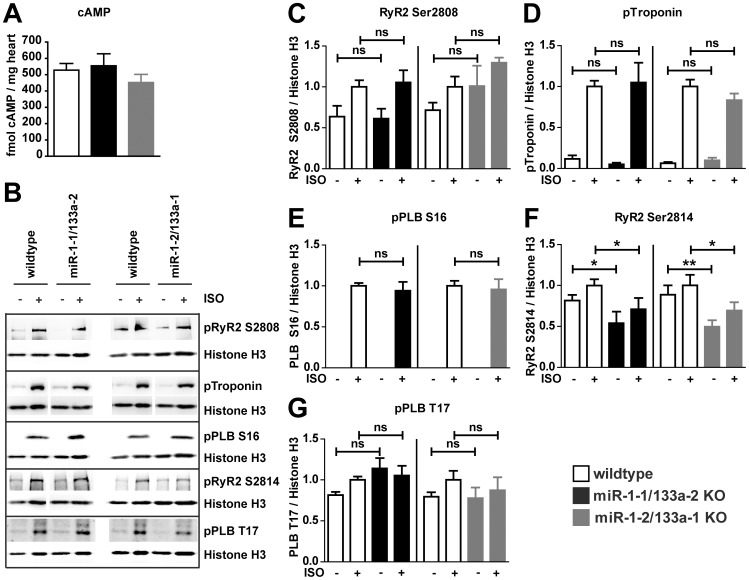
β-adrenergic signaling is intact in after loss of miR-1/133a.The concentration of cAMP was not changed in the adult heart of miR-1/133a single cluster mutant mice (A). Adrenergic signaling of cardiomyocytes isolated form adult hearts of WT and single miR-1/133a cluster mutant mice was investigated by stimulation with 1 µM Isoproterenol (ISO; B–G). Adrenergic signaling affects multiple components involved in cardiomyocyte calcium handling and contraction. Phosphorylation of several targets of the adrenergic signaling cascade was analyzed to detect modulation of the adrenergic signaling in cardiomyocytes isolated from mutant and WT animals. Proteins of cardiomyocytes isolated from of ≥5 animals was used for statistical evaluation (C–G), representative blots are shown (B).